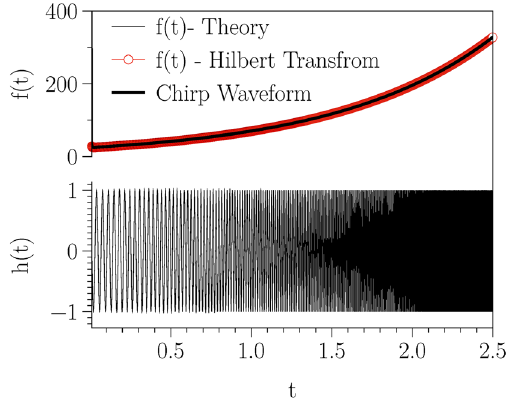
Figure 8. A chirp waveform and its Hilbert transform. A sinusoidal exponential chirp waveform and its theoretical time-dependent frequency as well as estimated frequency from Hilbert transform of discretized waveform. The waveform is plotted for the parameters are k = ( f 0 / f f ) 1 / T = 2.8 , with f 0 = 25 , f f = 550 and φ 0 = 0 .